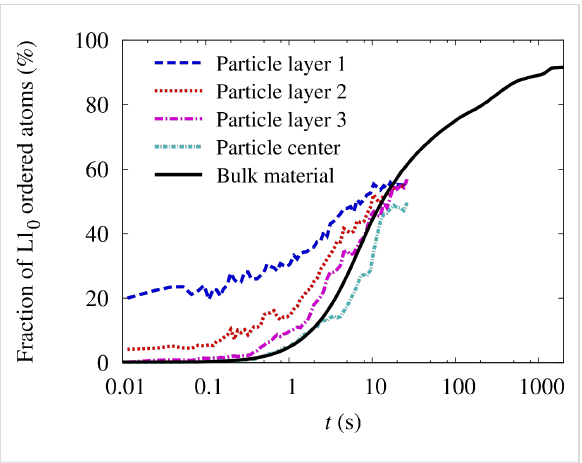
Figure 2: Evolution of ordering fraction in a free FePt nanoparticle of D = 5 nm compared to the case of bulk material. For analyzing the contribution of surface and volume effects, the particle has been divided into a spherical core of diameter of 3.2 nm, followed by three layers of thickness of 0.3 nm, with layer 1 denoting the surface. The temperature is 1000 K. Initially, the fraction of ordering was zero in all layers.